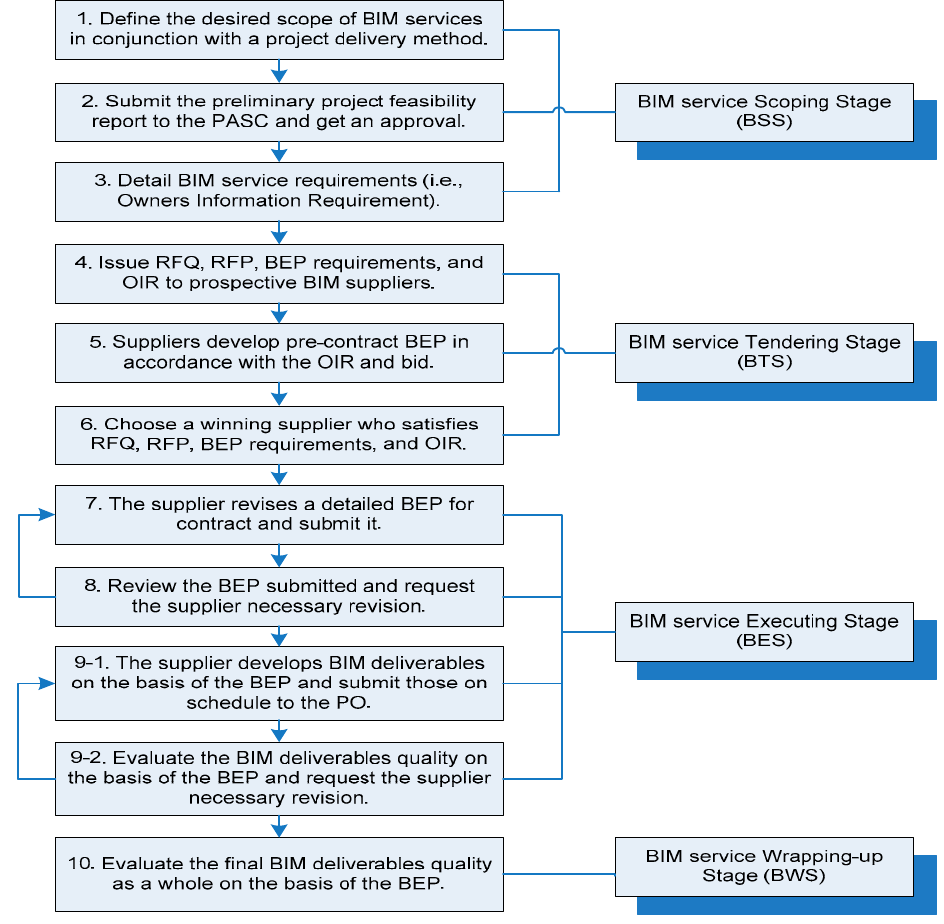
Figure 4. BIM services’ procurement stages identified.